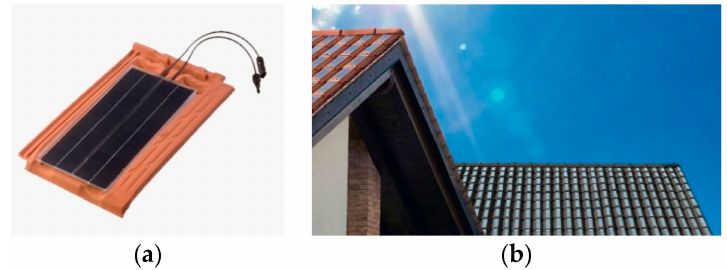
Figure 5. ( a ) Selected PV tile; ( b ) installation example.